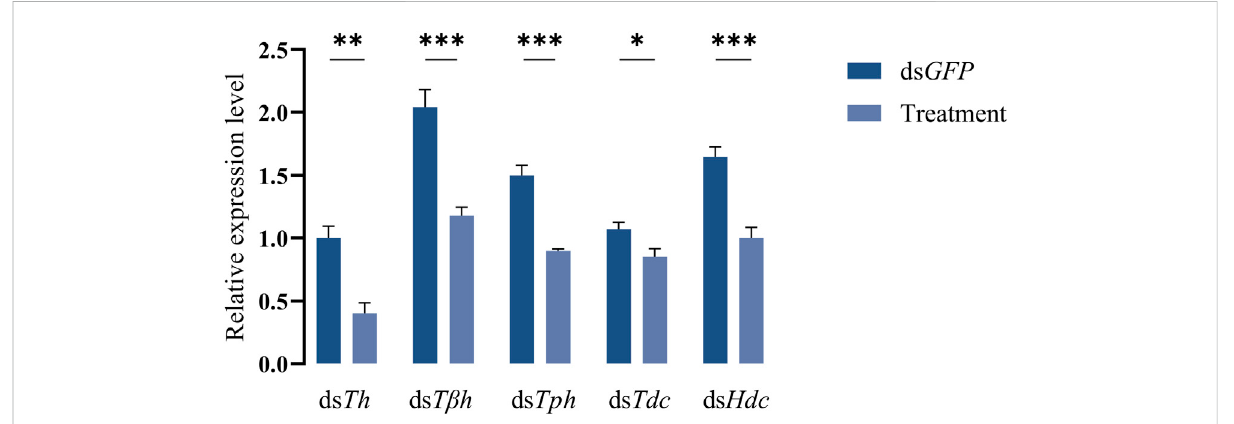
FIGURE 2 Ef fi ciencyofRNAi.The fl iesinjectedwithds GFP wereservedascontrol,andtreatmentsrepresentedthe fl iesreceivingdsRNAtargetingdifferent genes. Values are the means (±SEs) of replicates. Statistical comparisons were based on Students ’ s t test. The level of signi fi cance for the results was set at * p < 0.05, ** p < 0.01, *** p <